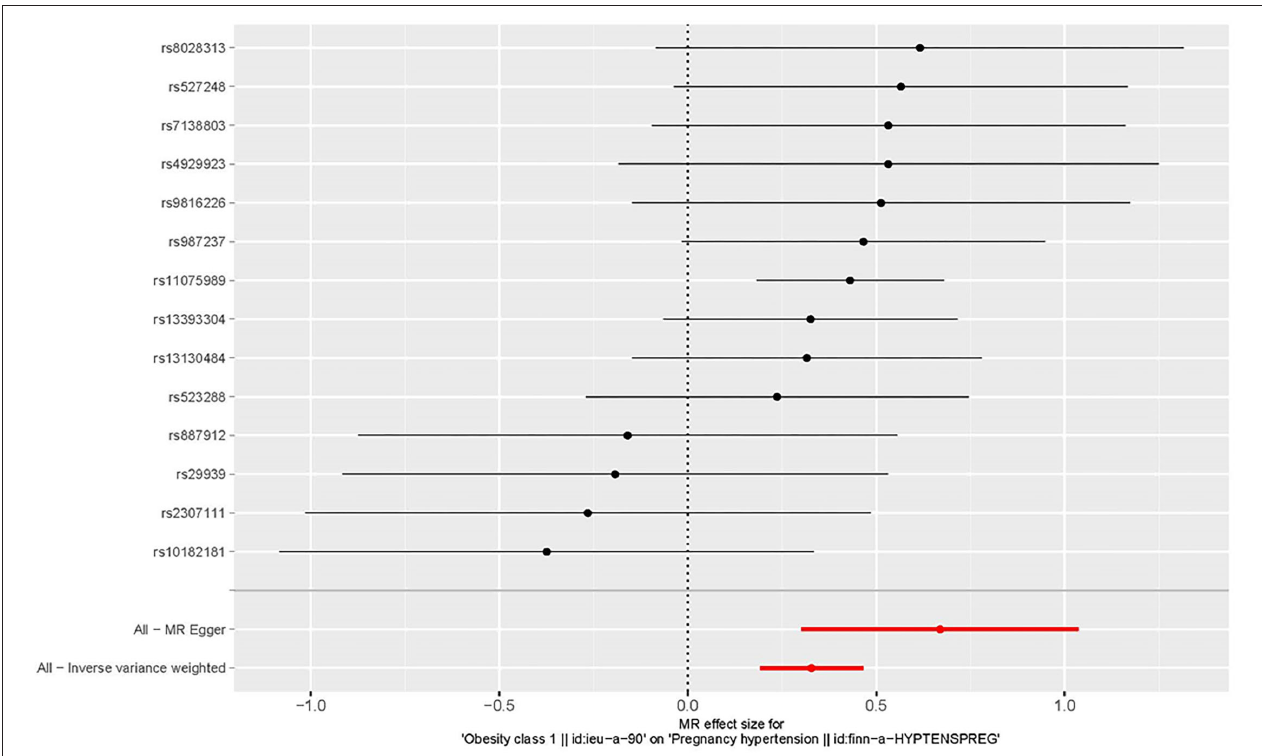
FIGURE 3 | Forest plot to visualize the causal effect of every single SNP on the risk of hypertension disorders in